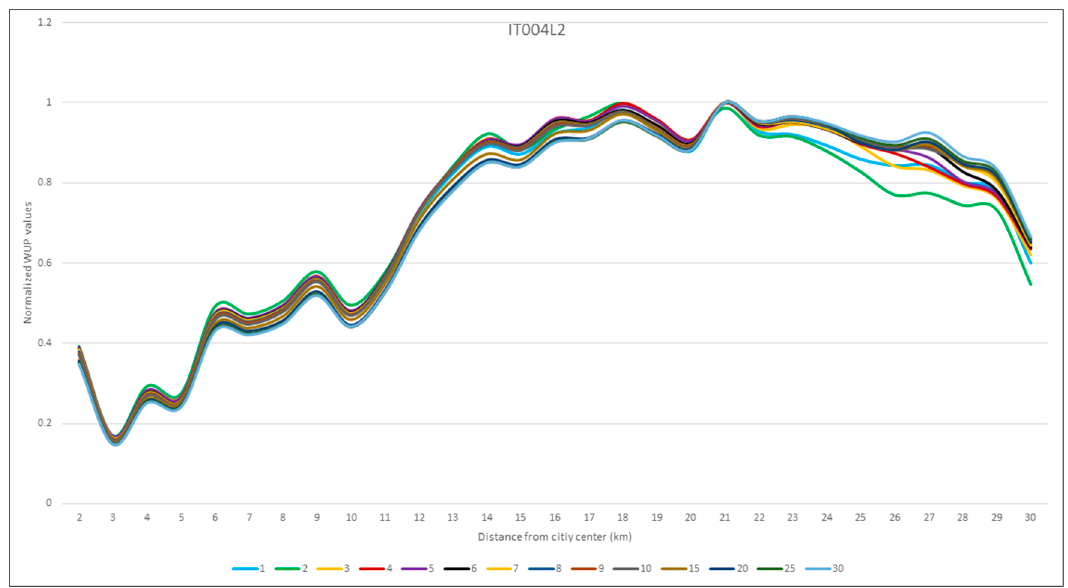
Figure 4. Normalized average WUP values per concentric rings extending from the city center, calculated for increasing horizons of perception for the city of Turin, Italy.